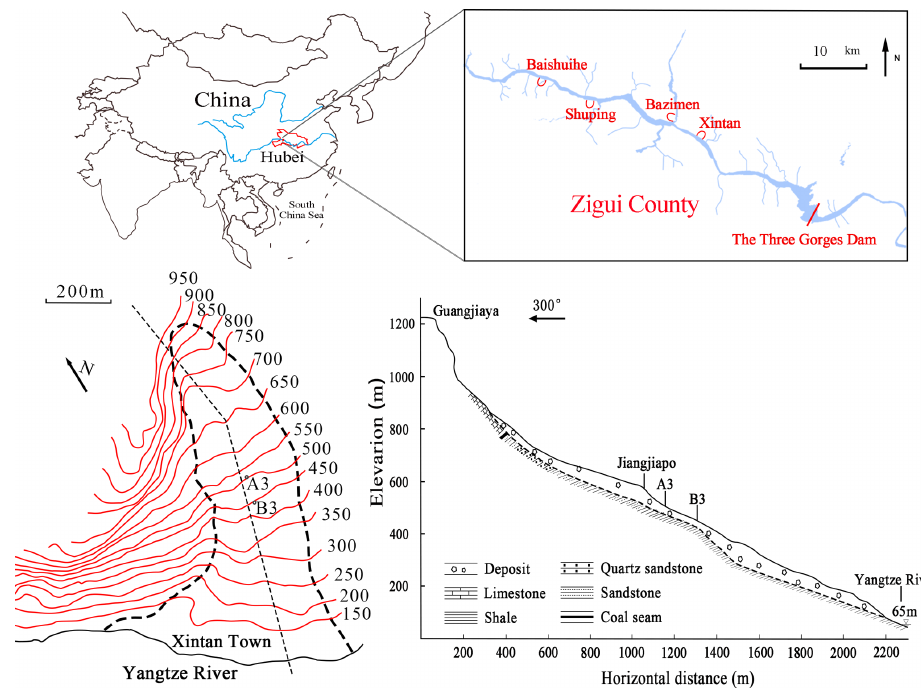
Figure 3. Location and plane/section of Xintan